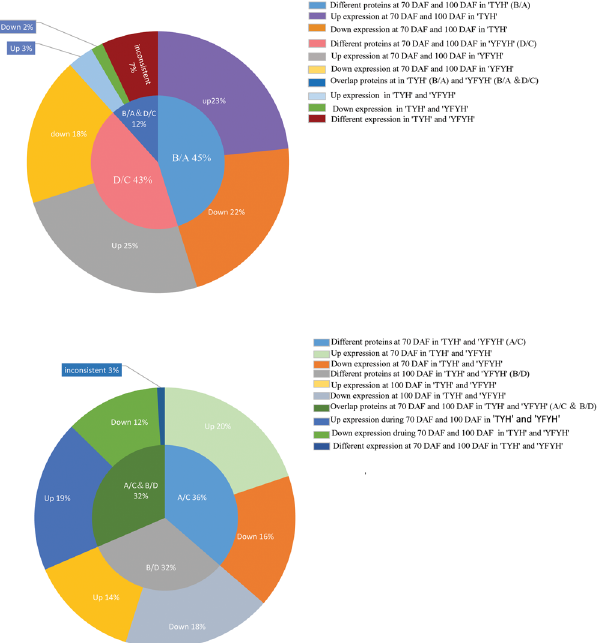
Figure 4. Venn diagram of the differentially abundant protein species in the 4 groups. ( a ) Comparison of proteins in ‘Tianyuanhong’ and ‘Yongfengyihao’ at 70 days and 100 days. ( b ) Comparison of proteins at 70 DAF in ‘Tianyuanhong’ and ‘Yongfengyihao’ and 100 DAF in ‘Tianyuanhong’ and